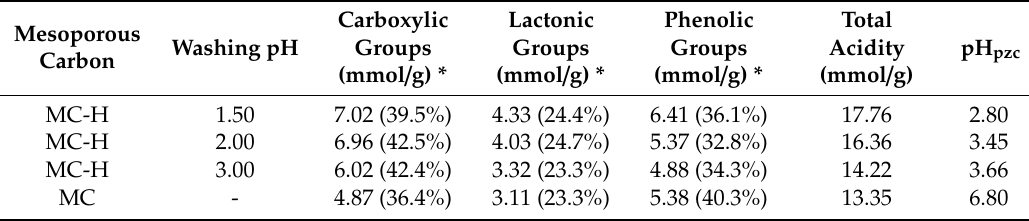
Table 1. Acidic properties (Boehm titration), as well as the pH at the point of zero charge (PZC),